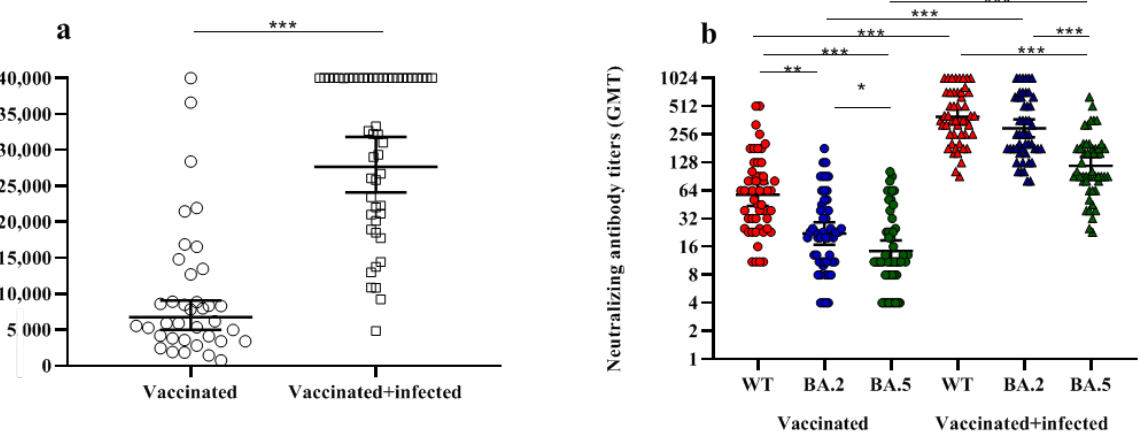
Figure 1. Immune response in vaccinated subjects, either infected with SARS-CoV-2 BA.1 variant or not. Anti-spike IgG antibody levels (Panel ( a )) and neutralizing SARS-CoV-2 antibodies (Panel ( b )) in serum samples of vaccinated subjects with three doses of mRNA vaccine, either infected (squares) or not (circles) with Omicron BA.1 strain. Differences in neutralizing IgG antibodies were evaluated against WT (red), BA.2 (blue), and BA.5 (green) strains (Panel ( b )). In each plot, the horizontal line represents the mean (Panel ( a )) or the geometric mean (Panel ( b )), while the top and bottom lines show the 95% confidence interval (CI 95%). The p values are reported in the figures, where * stands for p ≤ 0.05, ** for 0.05< p <0.001 and *** stands for p <